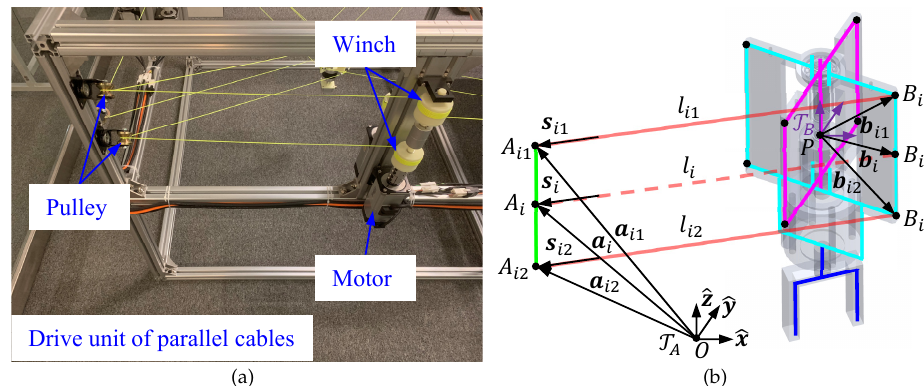
Figure 3. Working principle of parallel cables. ( a ) Drive unit. ( b ) Kinematic